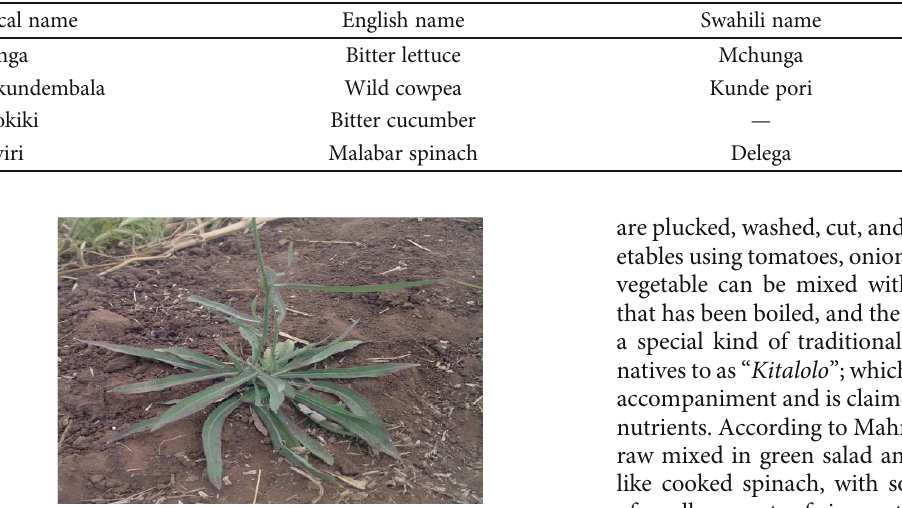
Table 2: List of the selected underutilised vegetables from the study areas.